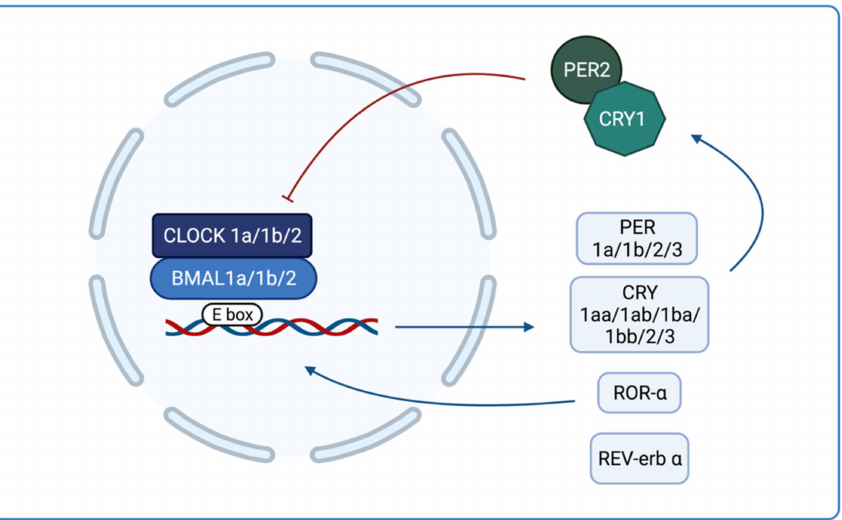
Figure 1. Molecular loop of zebrafish clock genes. Clock and Bmal1 form a heterodimer that activate the transcription of Per, Cry, ROR- α y REV-erb α . PER and CRY dimerize and inhibit the activity of Clock and Bmal1. ROR- α activates the BMAL1 expression and REV-erb α inhibits